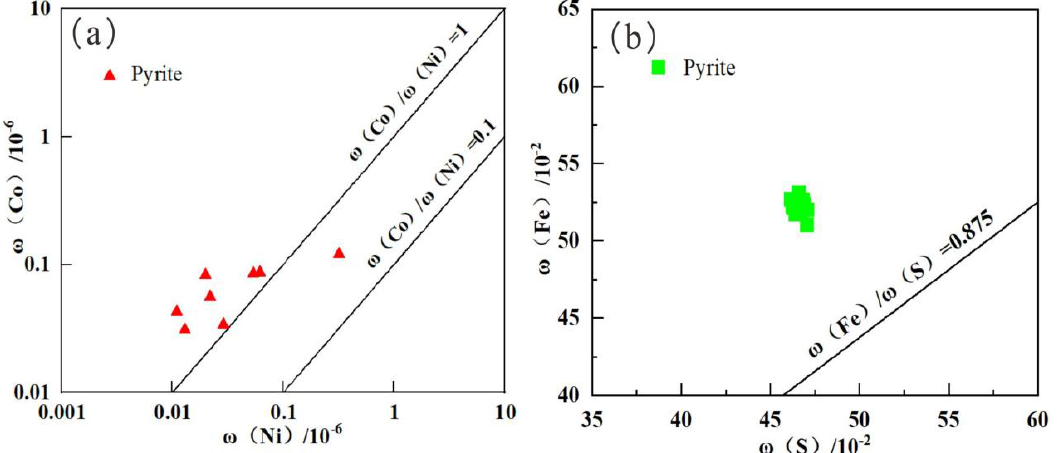
Figure 3. Pyrite typological characteristics. ( a ) Co ‐ Ni contents of pyrite; ( b ) Fe ‐ S contents of pyrite.